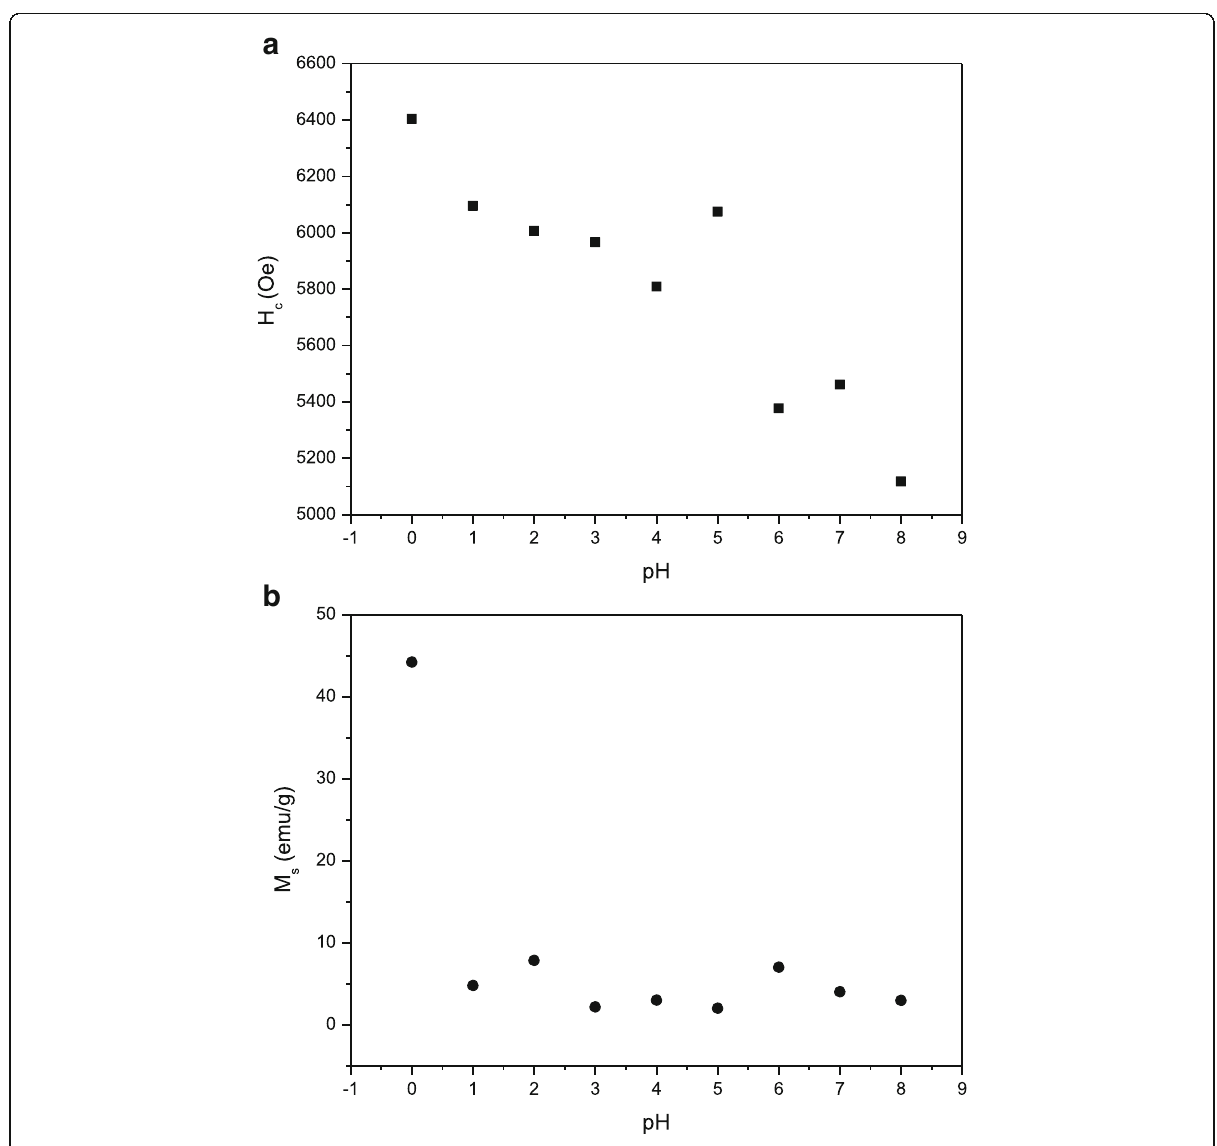
Fig. 9 a H c and b M s of SrFe 12 O 19 at varied pH sintered at 900